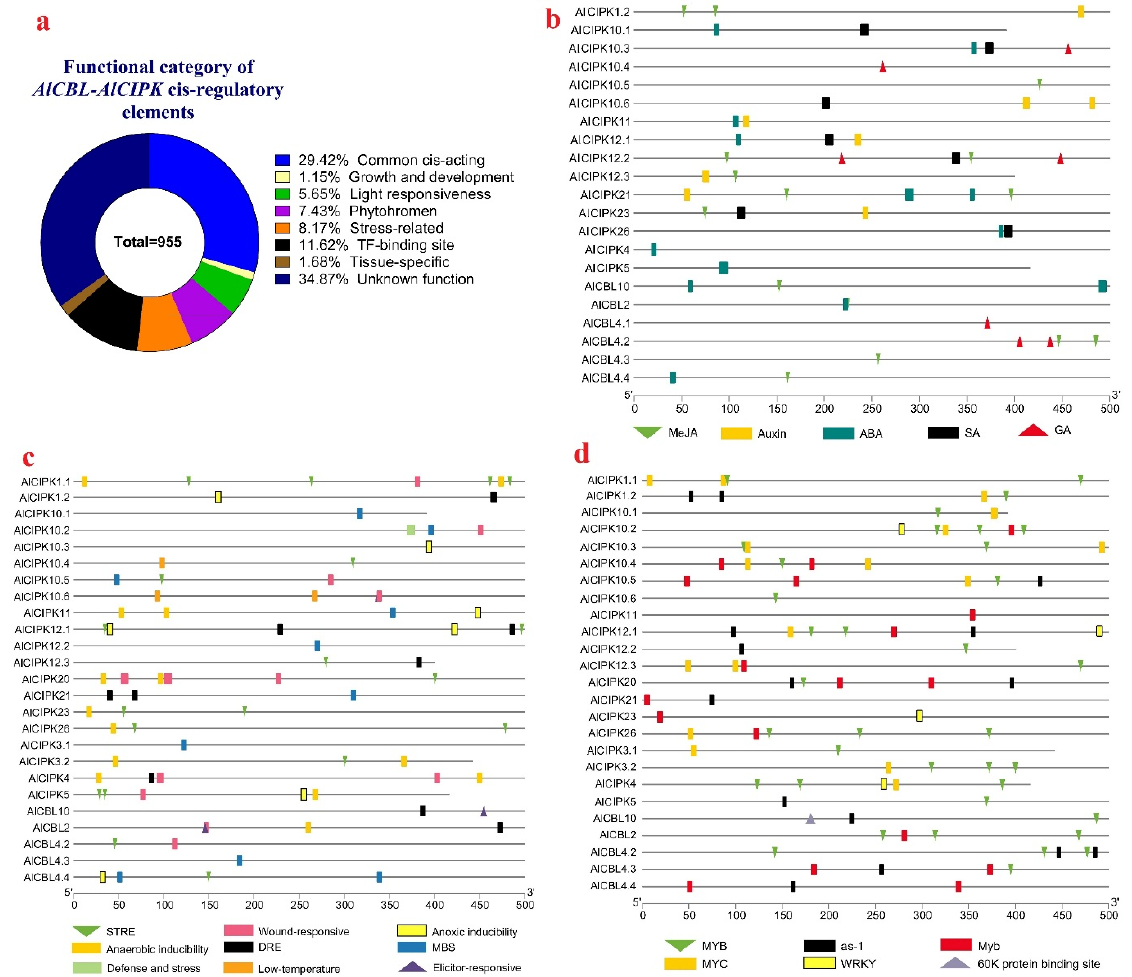
Figure 5. Distribution of cis -regulatory elements in the upstream of AlCBLs and ALCIPKs. Grouping of cis -regulatory elements based on their functions ( a ). Distribution of cis -regulatory elements involved in response to phytohormones ( b ), stress ( c ), and TF binding site ( d ). In this study, the upstream 1500 bp of AlCBL and AlCIPK genes was analyzed using PlantCARE.